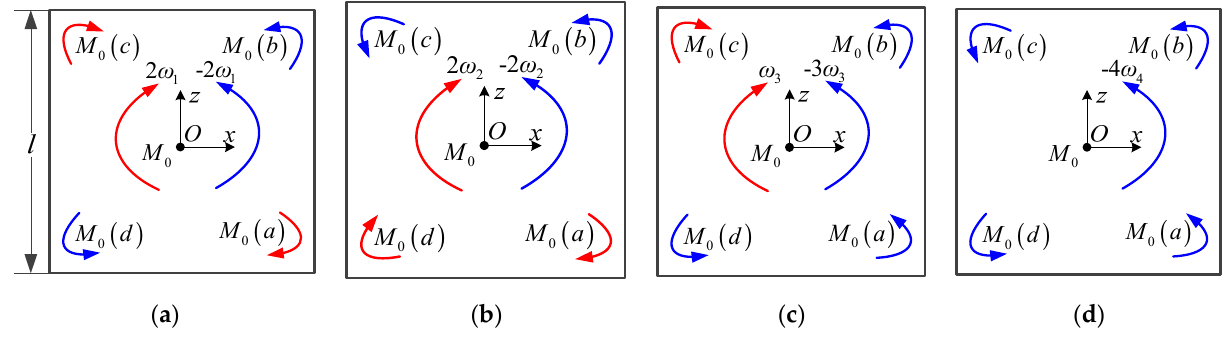
( d ) Figure 21. Simplified classification layout of the positioning axis. ( a ) Three-one orthogonal layout; ( b ) two-two diagonal orthogonal layout; ( c ) two-two unilateral orthogonal layout; ( d ) parallel lay- out. The movement direction of the capture hook is perpendicular to the axial direction of the positioning shaft. When the positioning shaft is arranged in a certain direction, the direction of the contact torque ( ) o M i for each group of hook frames is determined by the movement direction of the capture hook. If the contact force F i for each group of hook frames is equal during capture, the contact torque for each group of hook frames is